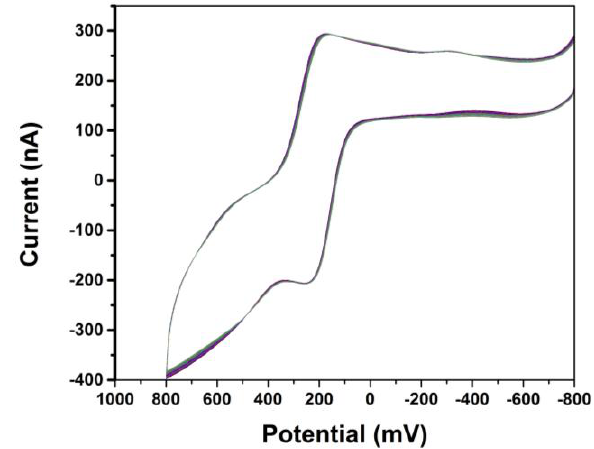
Figure 2. CV for FCA on a microelectrode array (scans